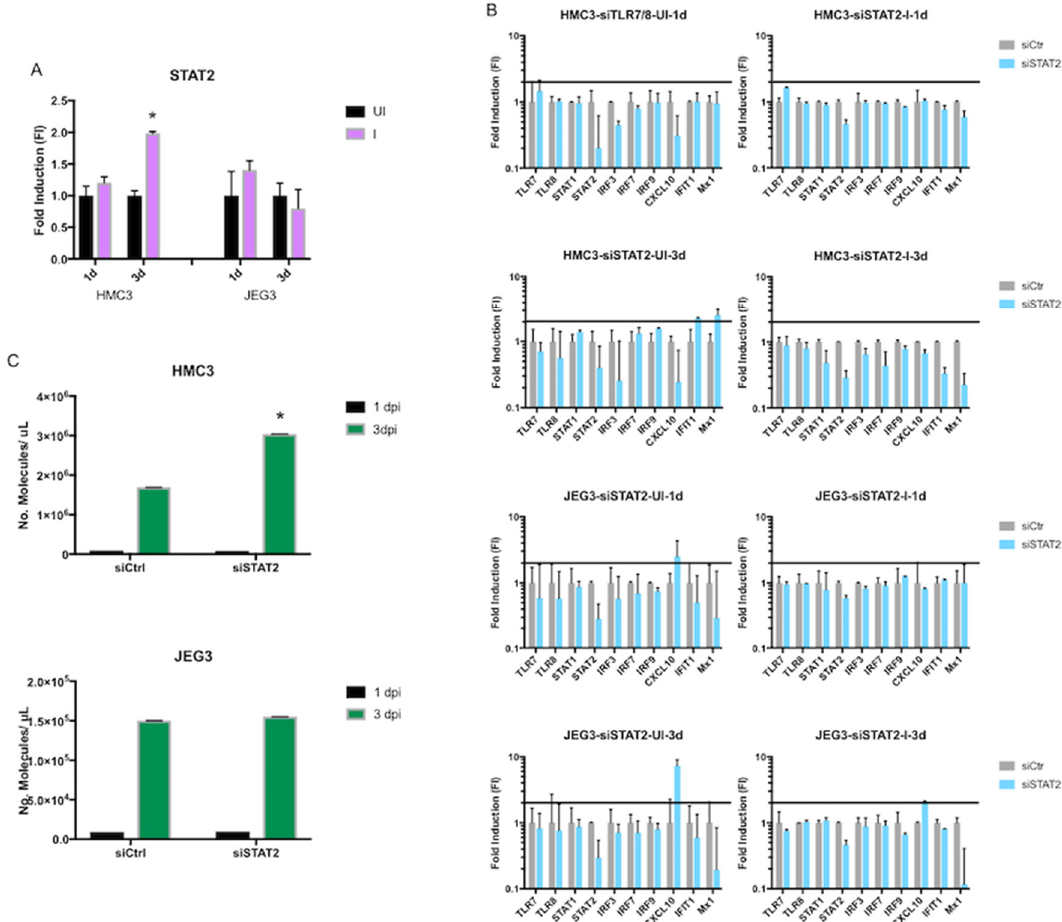
Figure 6. Role of STAT2 in ZIKV replication and in the intracellular response to infection. ( A ) STAT2 expression in time-matched mock-infected (UI) and ZIKV-infected (I) HMC3 and JEG-3 cells at one dpi and three dpi. ( B ) Effect of STAT2 knockdown on selected innate immune genes in time-matched mock-infected (UI) and infected (I) HMC3 and JEG-3 cells at one dpi and three dpi. The horizontal black line represents the two-fold induction (FI) threshold in each plot. ( C ) Number of ZIKV RNA molecules detected from the total RNA collected from cells treated with siRNAs against STAT2. (* p < 0.05).